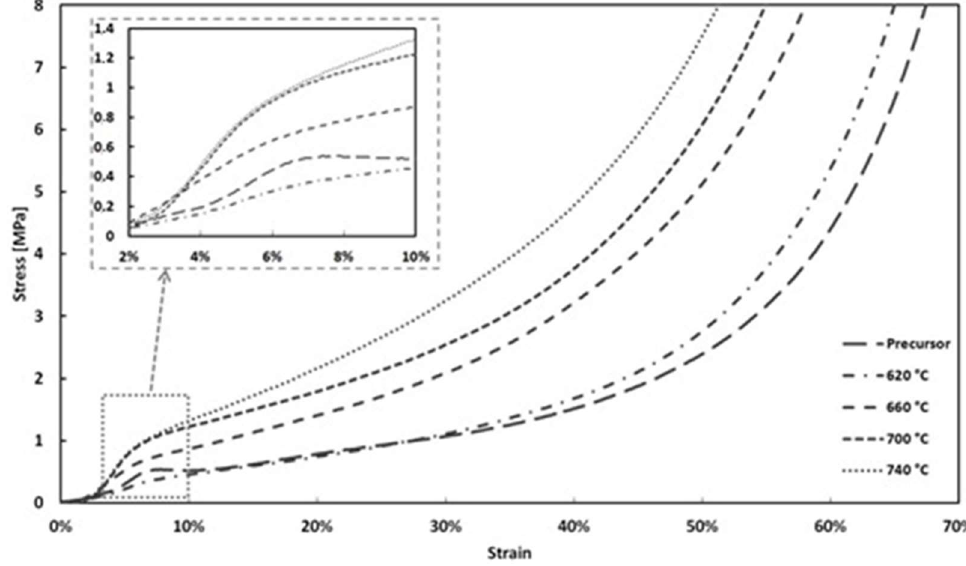
Figure 7. Stress–strain curves for aluminum foams in various sintering temperatures.